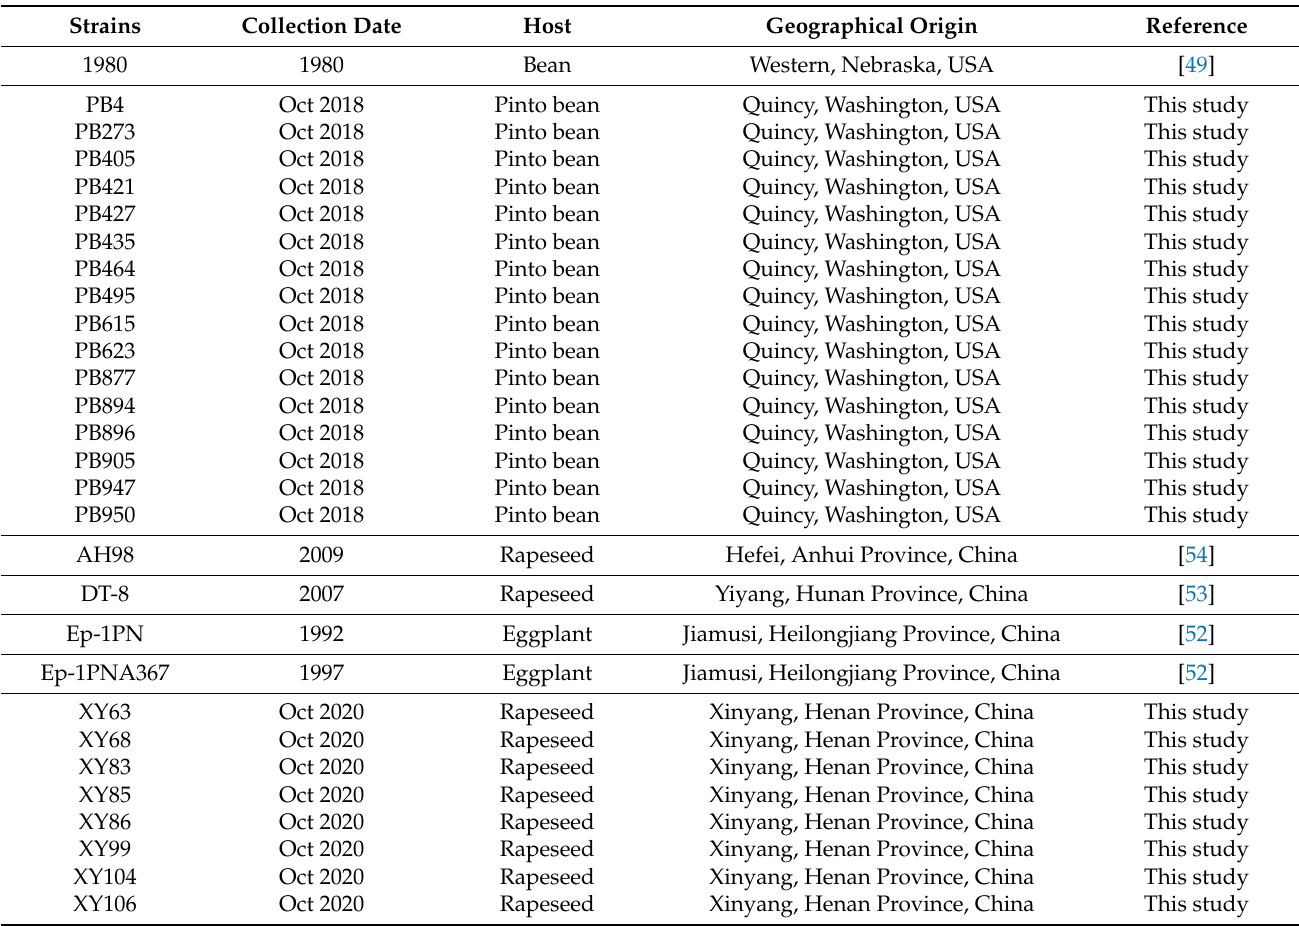
Table 1. List of Sclerotinia sclerotiorum strains used in the